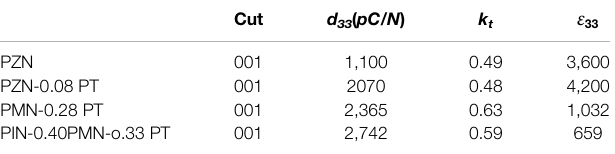
TABLE 1 | Performance parameters of relaxor-based materials-thickness vibration